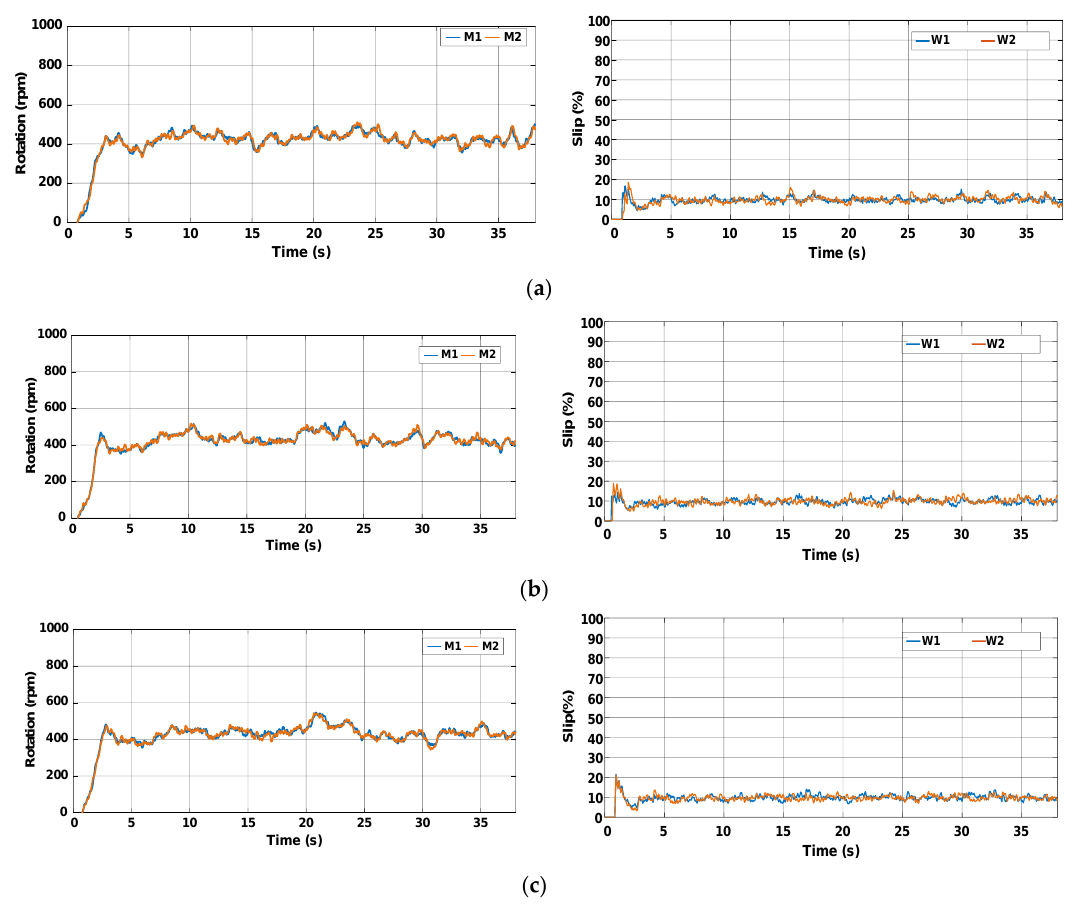
Figure 25. Rotation speed of electric motors and wheel slip during the trial sessions carried out on firm soil with the slip automatically adjusted by the proposed control scheme. ( a ) T#3.1; ( b ) T#3.2; ( c ) T#3.3.